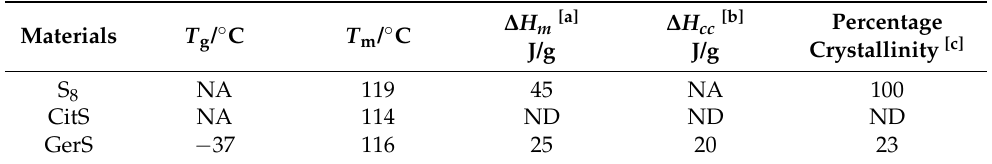
Properties of terpenoid–sulfur cement binders and comparison to elemental sulfur